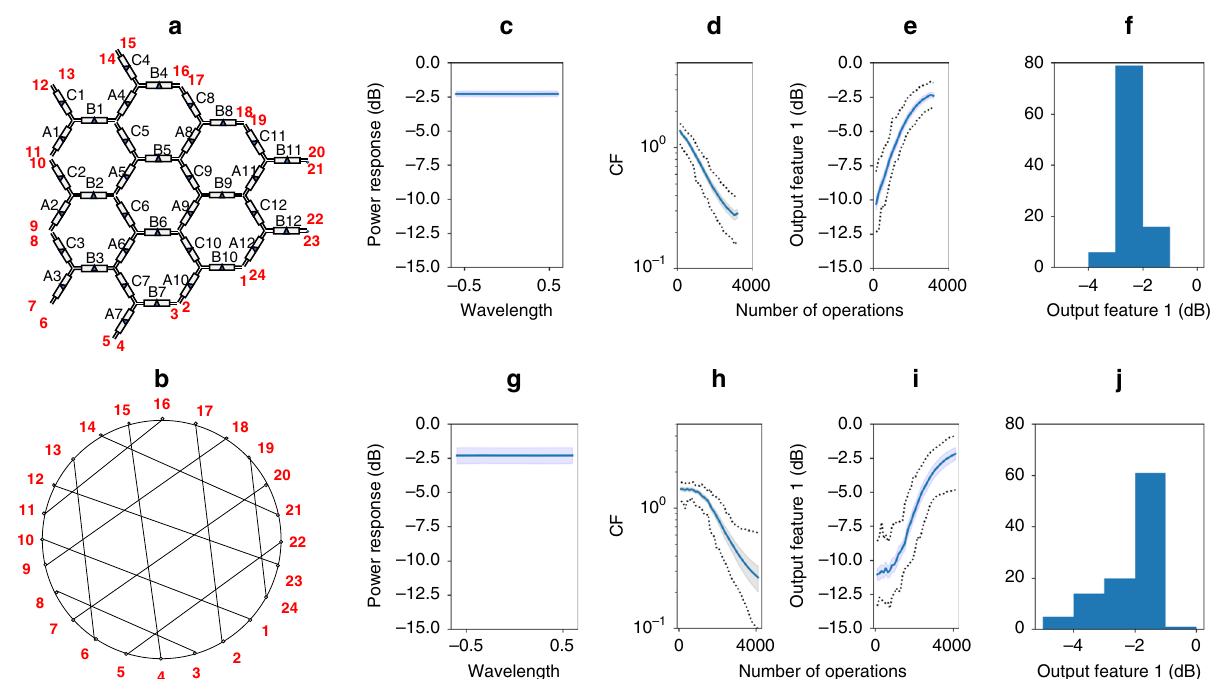
Fig. 3 Numerical results for the self-con fi guring of an all-cross function in a 36 TB hexagonal waveguide mesh. Note that the process involves using computational optimization methods and no prior structure testing or calibration is employed. a Labeled schematic of the waveguide mesh arrangement under test with both TBU (black) and port (red) labels. b Black box system with the targeted performance, where the system performs an optical routing between channels de fi ned by the port pairs 12 – 23, 14 – 21, 10 – 1, 8 – 3, 13 – 6, 15 – 4, 17 – 2, 19 – 24, and 11 – 16, 9 – 18, 7 – 20, 5 – 22. Note: they represent direct connections without crossings or splitting. All-cross function statistical results for fi xed hyperparameter selection with c – f genetic algorithm and g – j particle swarm optimization for CF all-cross 1 . From left to right: c , g spectral response versus wavelength normalized to the basic unit delay (BUD) 25 , d , h evolution of the average (solid), maximum and minimum (dotted), and standard deviation (shaded) cost function, and e , i output feature(OF) and f , j histogram of the last operation (OF1: average of normalized output channels power of the beamsplitters, the datasheet is composed of 100